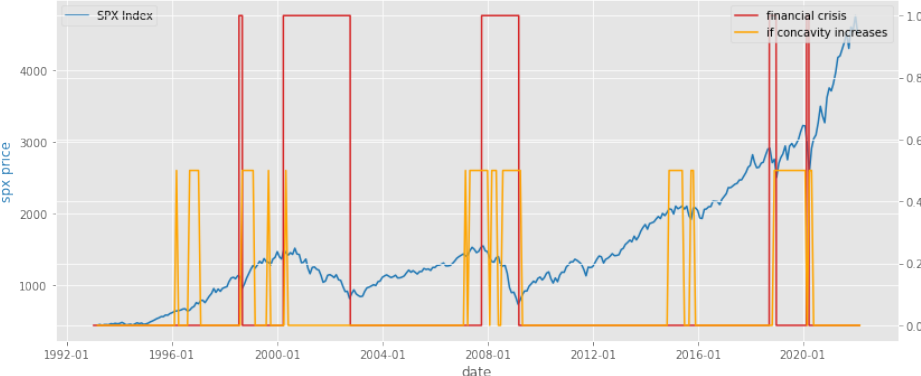
Figure 4. Comparing concavity with its 90th